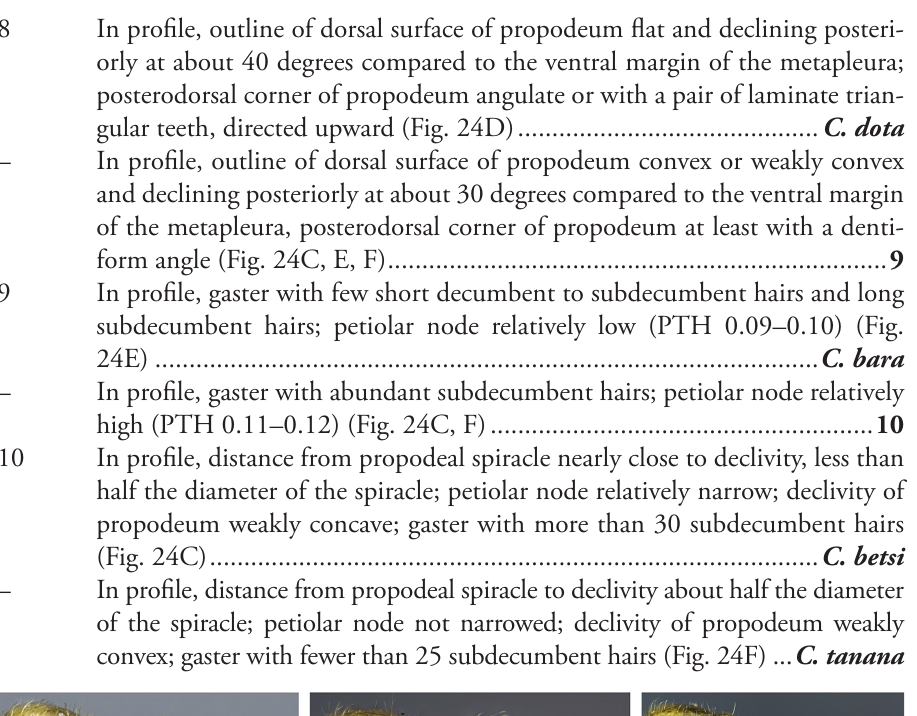
In profile, outline of dorsal surface of propodeum flat and declining posteri- orly at about 40 degrees compared to the ventral margin of the metapleura; posterodorsal corner of propodeum angulate or with a pair of laminate trian- gular teeth, directed upward (Fig. 24D) ............................................ C. dota